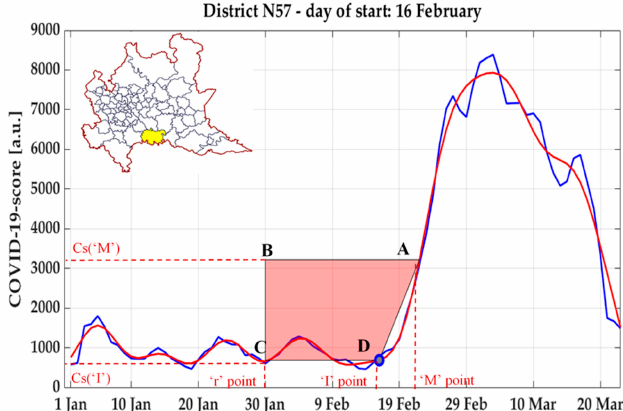
Figure 5. Example of the computed “COVID-19-score” (a-dimensional unit_ (blue—the original values; red—after low-pass filtering) from 1 January to 23 March 2020 for the spatial cluster (yellow area in the map) including the town of Codogno, from which the fiducial points for the generation of the trapezium ABCD were derived (see text for details). By an iterative process, the area of the ABCD trapezium is computed for each possible position of the vertex D changing its x-coordinate I on every value of the filtered (red) signal (from “M” to “r”). The position of D in which the trapezoid area is maximal is considered as the inflection point “I” in the curve, thus corresponding to the beginning of the spread of the disease. By analyzing the time-series obtained of COVID-19 score and NEC over the clusters, different morphologies were observed and categorized into four classes (examples reported in Figure 6):